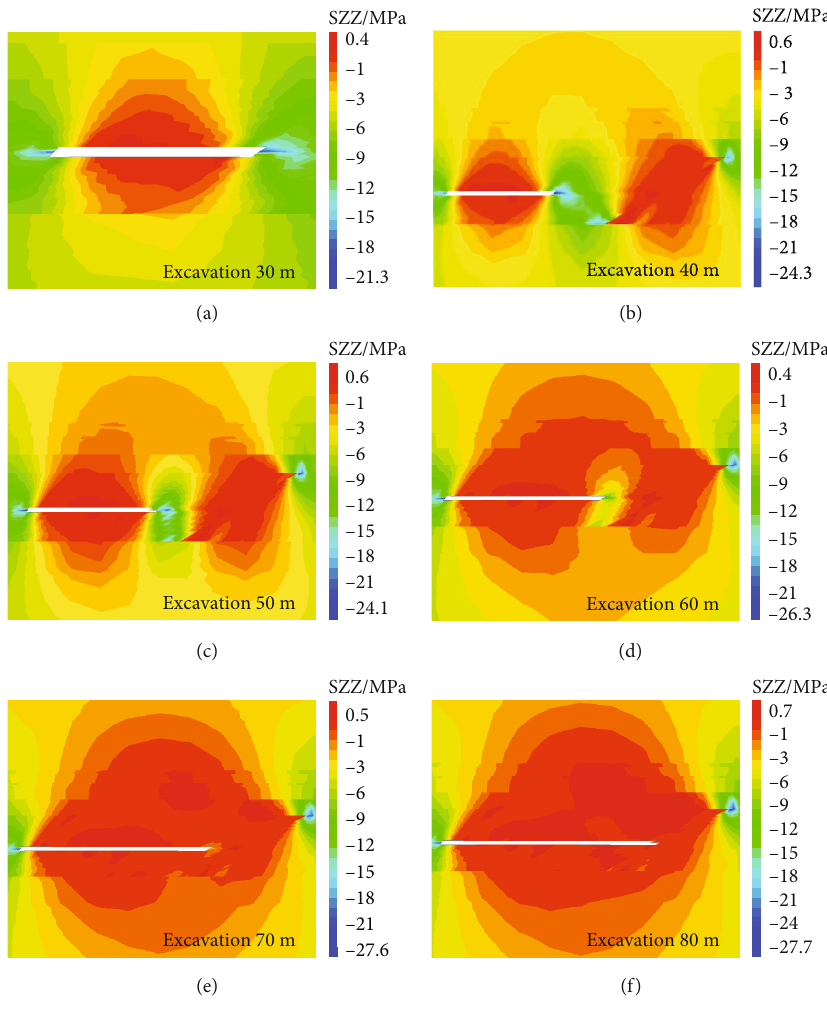
Figure 6: Stress distribution